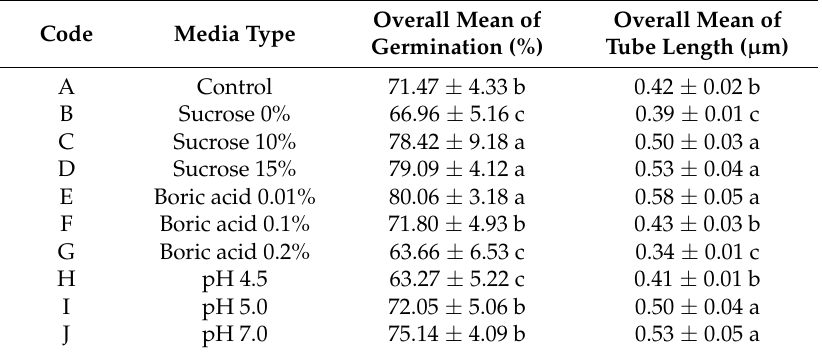
Table 8. The effect of different media types on pollen germination and tube